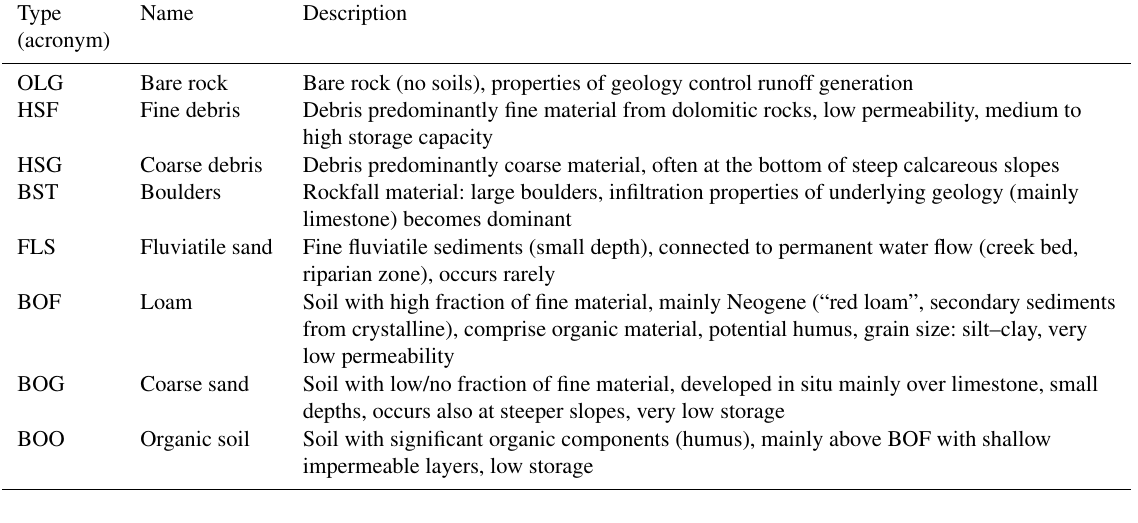
Table 3. Classification of “soils and debris” type into 8 classes.